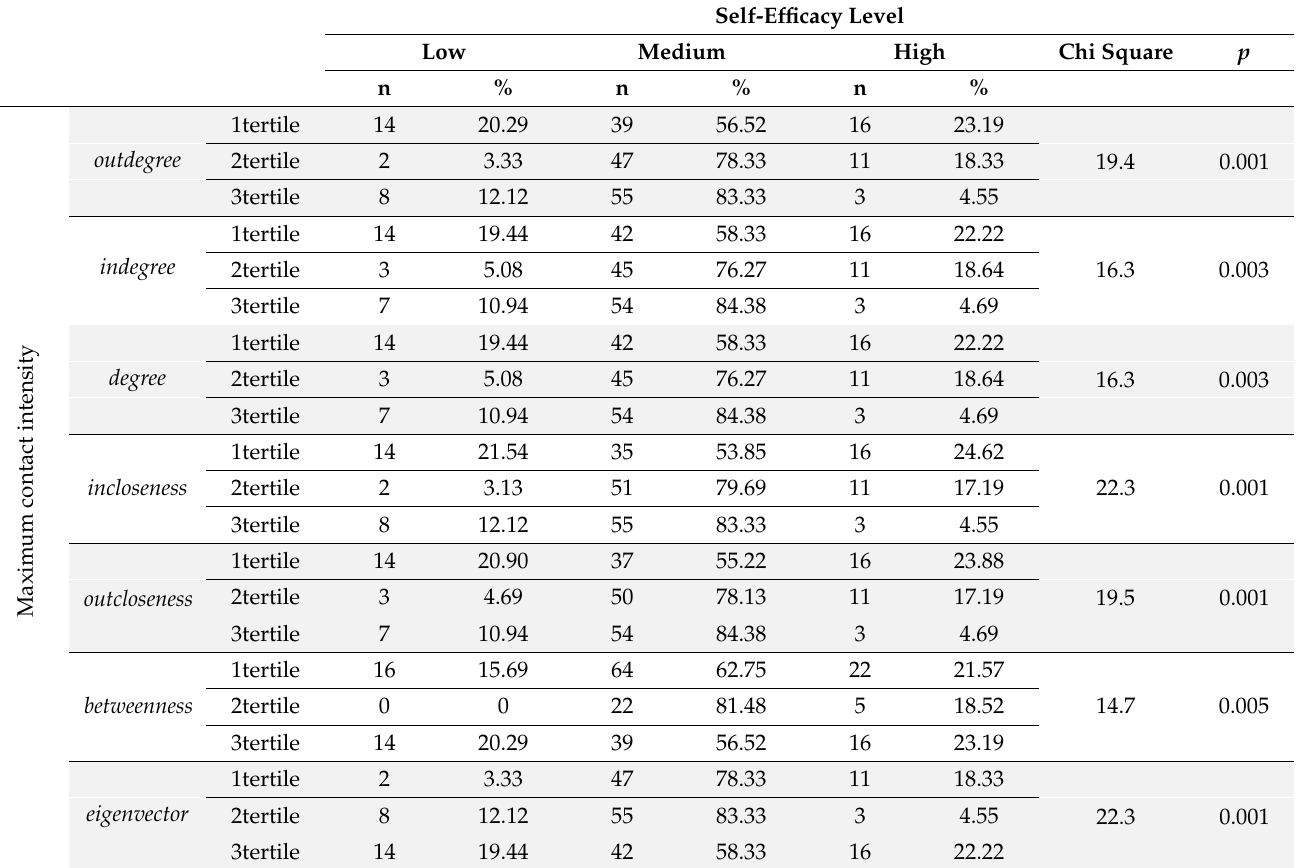
Table 4. Centrality indicators in relation to self-efficacy. (In Maximum contact